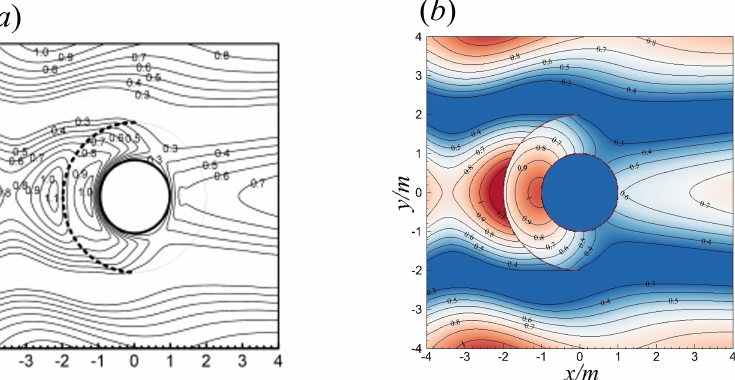
Figure 4. Comparison of the dimensionless wave surface distribution with a = 2 m, b = 1 m, √ h / a = 1, k x = k y = 2/2, U 0 = 0, G = 1, γ = π , and k x / k = ( b ) analytical results